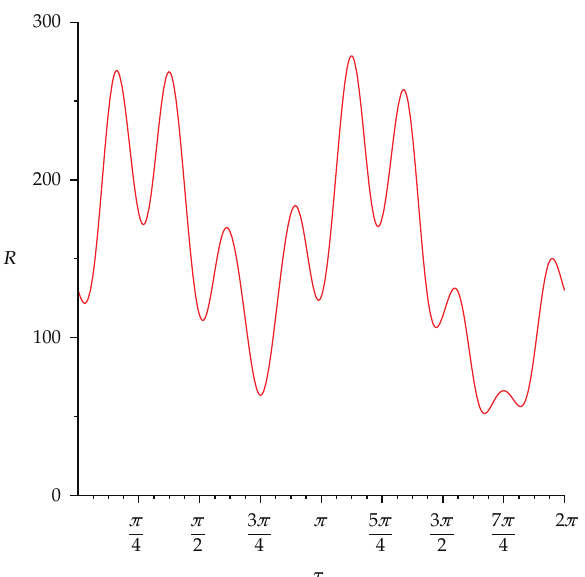
Figure 28: The evolution of the R with respect of the cosmic time τ for (cid:2) 5.13 (cid:3)